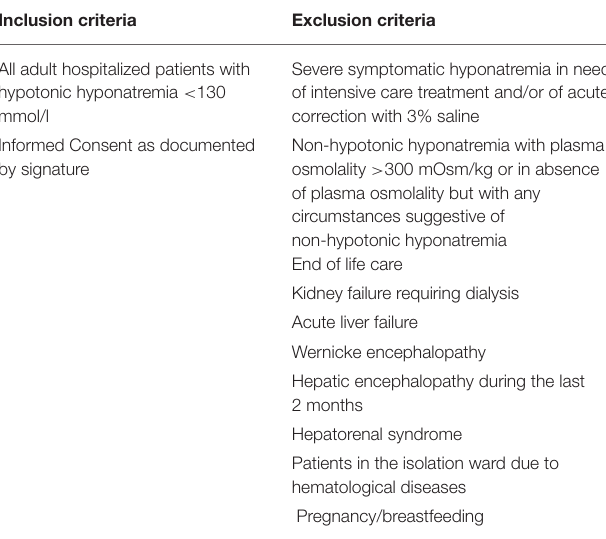
TABLE 1 | Inclusion and exclusion criteria. Inclusion criteria Exclusion